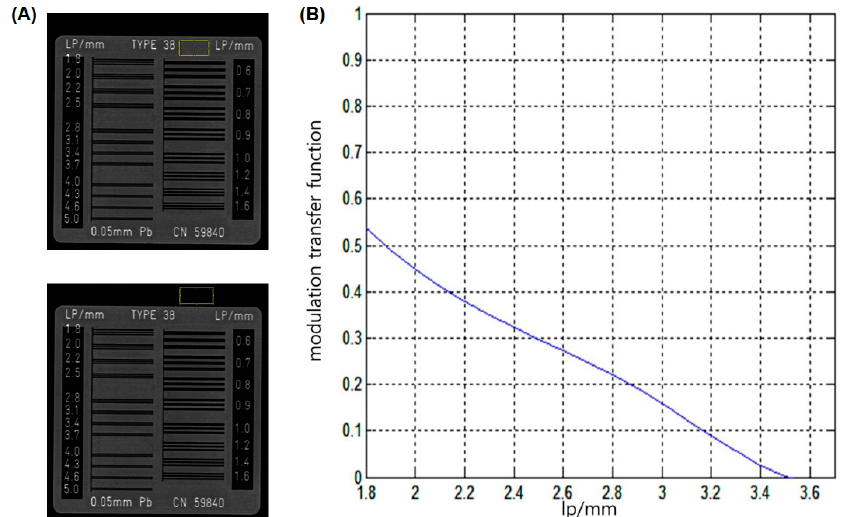
Figure 5. Bar phantom image obtained from the PDR to calculate the signal-to-noise ratio (SNR), contrast-to-noise ratio (CNR) and spatial resolution ( A ). Line-squares on the phantom images indicated the regions of interest for SNR and CNR measurements. A modulation transfer function (MTF, 10%) curve was used for resolution evaluation ( B ). The 10% MTF value is 3.17 lp/mm (157 μ m) on the image obtained from the PDR.